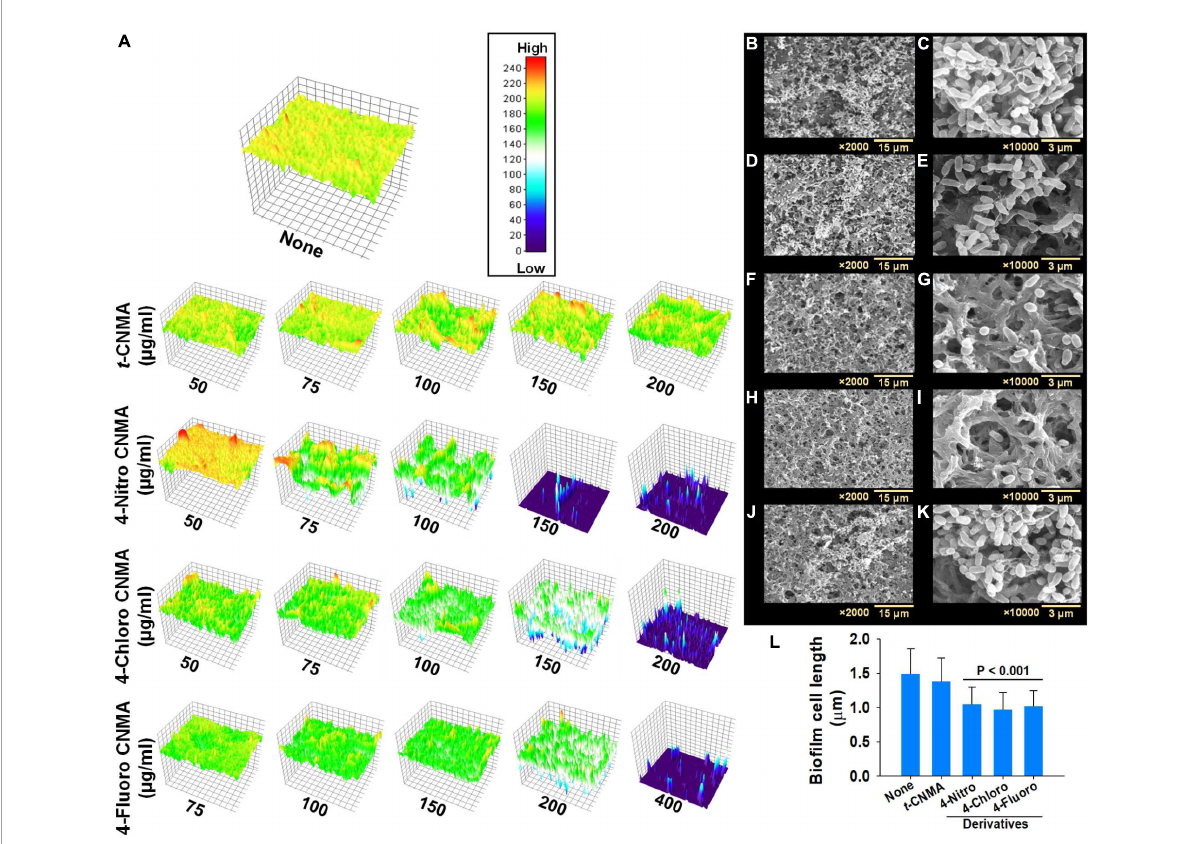
FIGURE3 Visual assessment of A. tumefaciens biofilm thicknesses formed on polystyrene after exposure to increasing concentrations of t -CNMA, 4-nitro CNMA, 4-chloro CNMA, or 4-fluoro CNMA. The colored 3-D images show biofilm thicknesses (A) on a low to high (0–200) scale, where red indicates maximum biofilm formation and dark blue no biofilm formation. Biofilms of non-treated (B,C) A. tumefaciens on nylon and its inhibition by t -CNMA (D,E) , 4-nitro CNMA (F,G) , 4-chloro CNMA (H,I) , and 4-fluoro CNMA (J,K) after incubation for 48 h. Micrographs taken at 2,000 × and 10,000 × revealed complete inhibition by 4-nitro and 4-chloro CNMA and reductions in cell lengths (L) , although t -CNMA (E) and 4-fluoro CNMA (K) showed biofilm with the presence of EPS